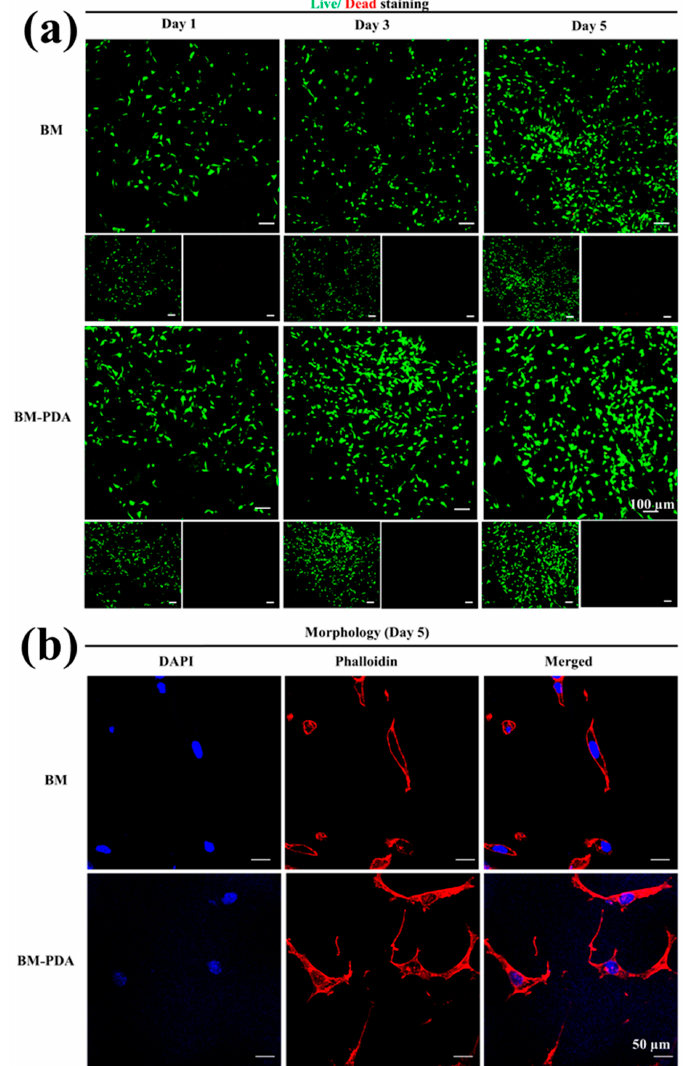
Figure 9. ( a ) Live ˗ dead assay displaying illustrations of live and dead L929 cells on the BM and BM ˗ PDA scaffolds on days 1, 3, and 5. Scale bar = 100 μ m. ( b ) Illustrative CLSM images of cells on the surface of BM and BM ˗ PDA scaffolds after 5 days of culture. Scale bar = 50 μ m Data are stated as mean ± SD ( n = 3).